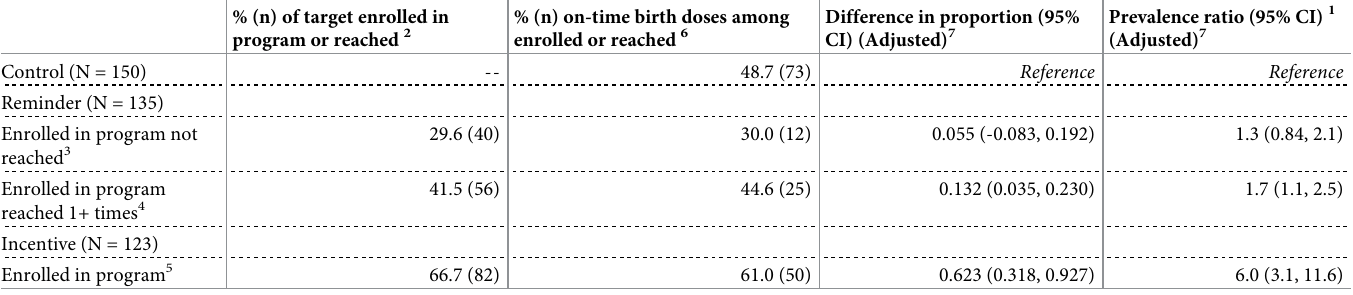
Table 4. Effect of participation in GEVaP intervention on timely vaccination with first dose of Polio and BCG vaccine [Per-protocol] (Intervention period N = 408). % (n) of target enrolled in % (n) on-time birth doses among enrolled or reached program or reached 2